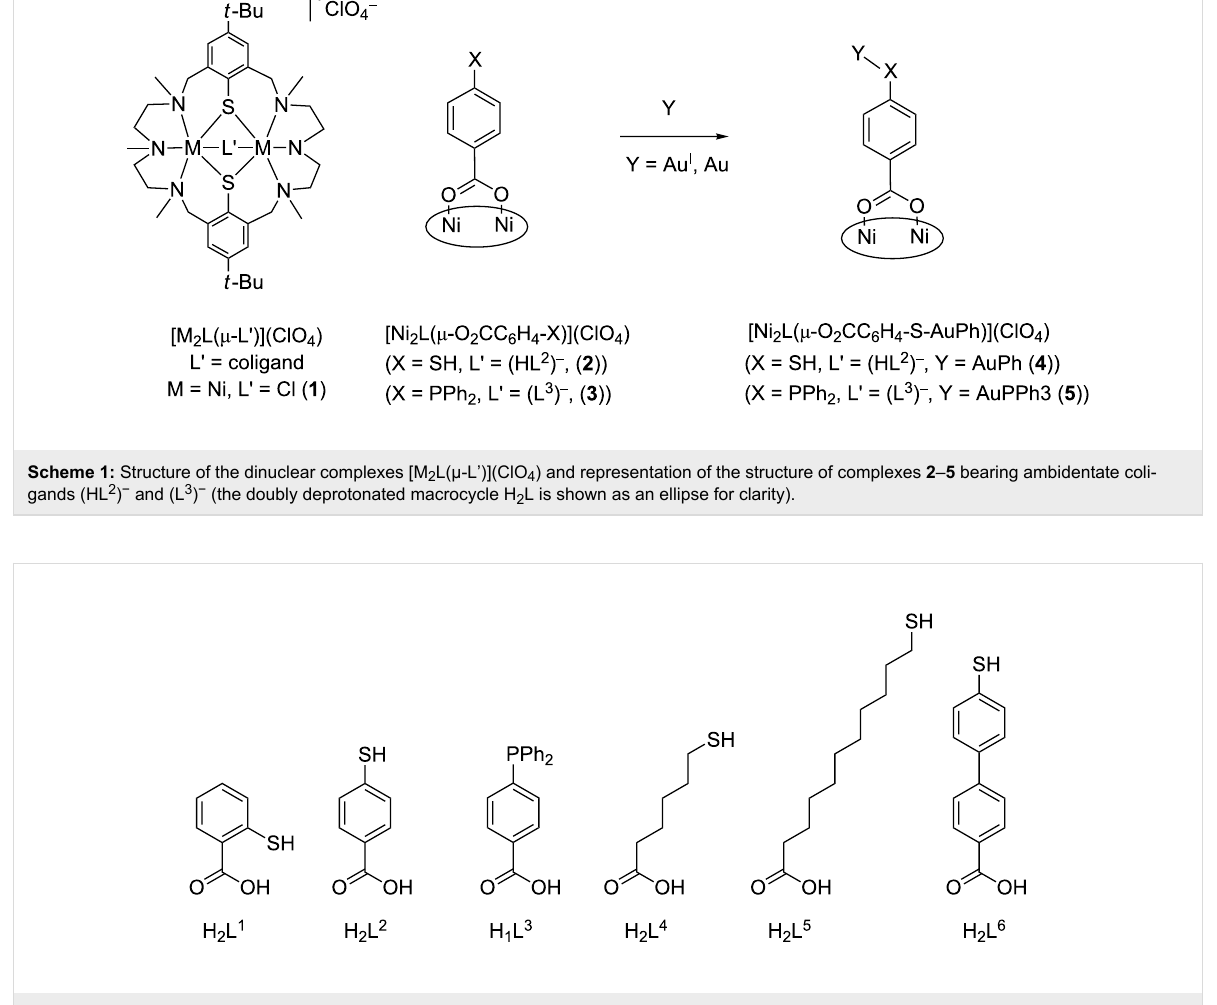
Figure 1: Ambidentate ligands with soft (–SH, –PPh 2 ) and hard (–CO 2 H) donor